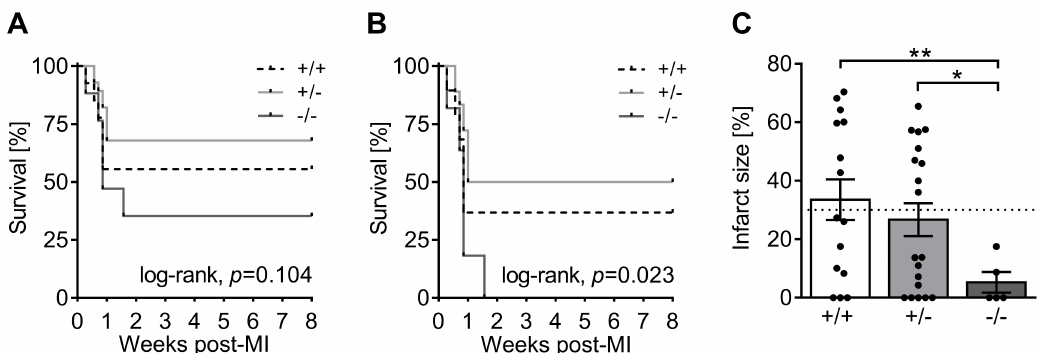
Figure 3. Survival of 5-HTT − / − mice is severely impaired after MI. ( A , B ) Kaplan–Meier survival curves of ( A ) all mice subjected to MI surgery show no statistically significant difference between 5-Htt genotypes, but ( B ) among those animals with large infarcts survival is severely impaired in 5-HTT − / − mice. ( C ) Histological quantification of the infarct size (fraction of the infarcted left ventricle) 8 weeks after surgery showed that none of the surviving 5-HTT − / − mice had a large (>30%) MI. Dashed line indicates the cut-off value of 30% for stratification into groups with small (<30%) and large (>30%) MI size. Values are shown as mean ± SEM. ( A , B ) log-rank test, ( C ) Welch’s ANOVA with Games–Howell post hoc test. * p < 0.05, ** p <